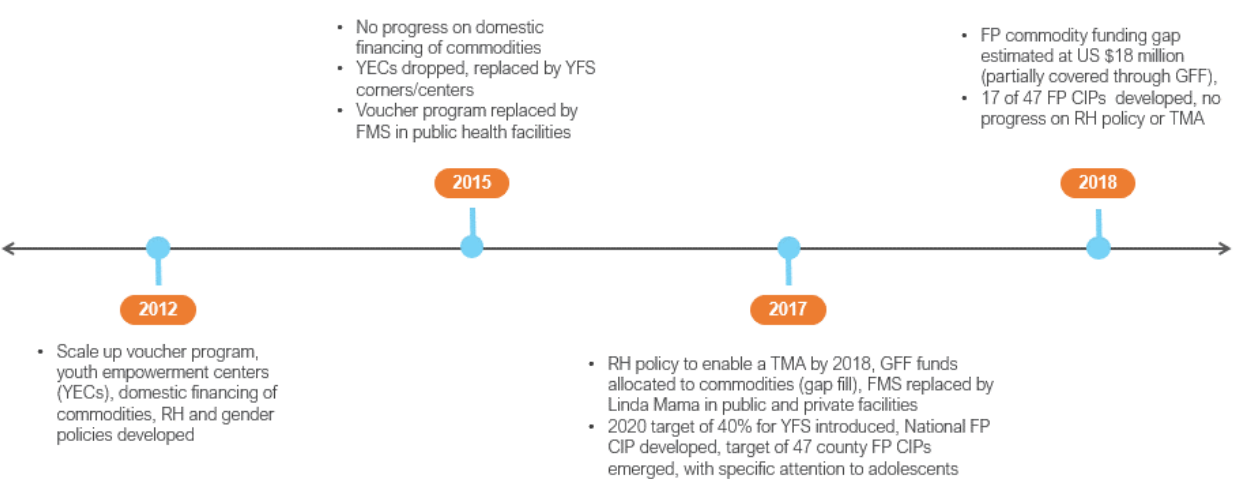
Figure 1. Kenya FP2020 commitments and timeline. YECs – youth empowerment centres; RH – reproductive health; YFS – youth friendly services; FMS – free maternity services; TMA – total market approach; GFF – Global Financing Facility; CIP – costed implementation